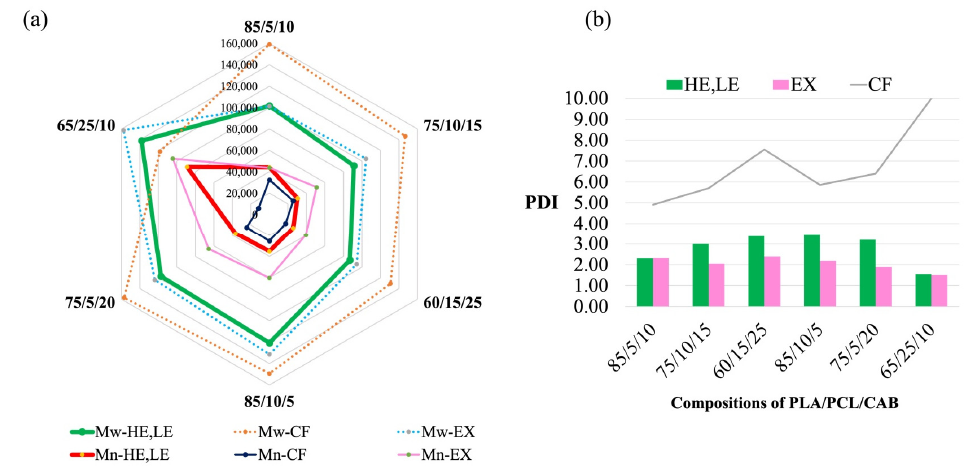
Figure 8. Molecular weights ( M w and M n ) of ternary-blended, melt-blown films (HE, LE), ternary- blended, melt-extruded pellets (EX) and solvent-casted films (CF) of PLA/PCL/CAB at different compositions ( a ), and their polydispersity (PDI) ( b ).